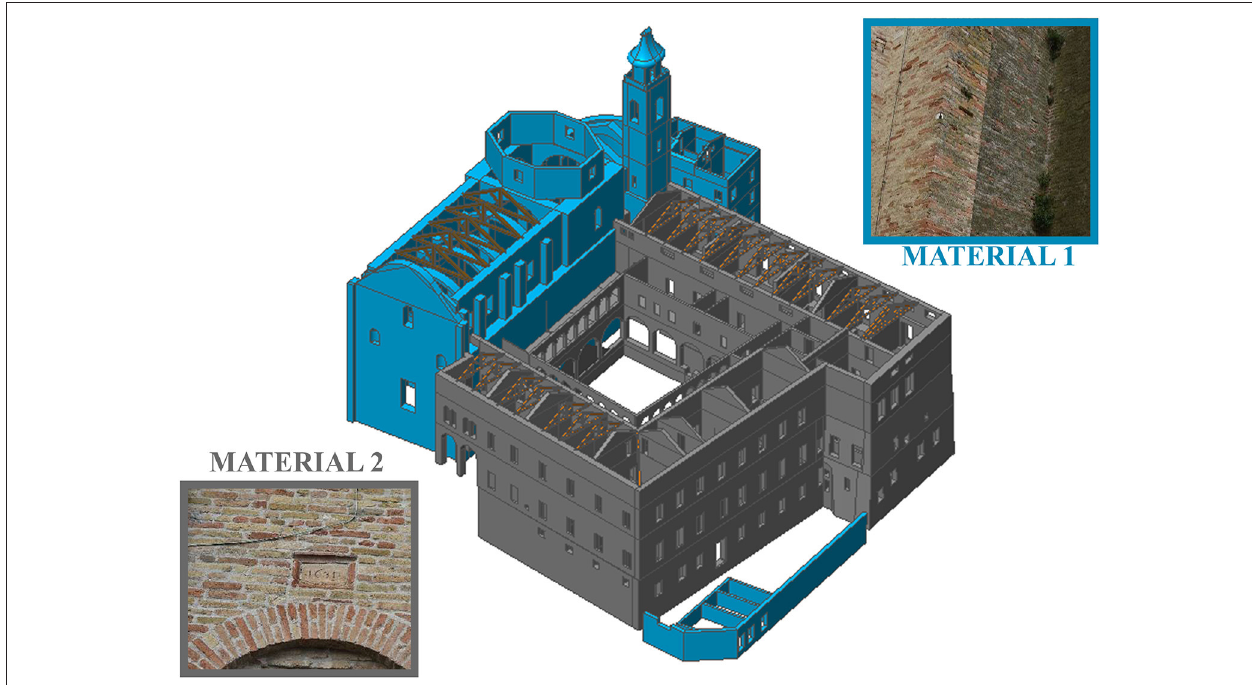
FIGURE 2 | Technological characterizations of materials of “Sant‘Agostino’s Sanctuary” in Offida (AP).